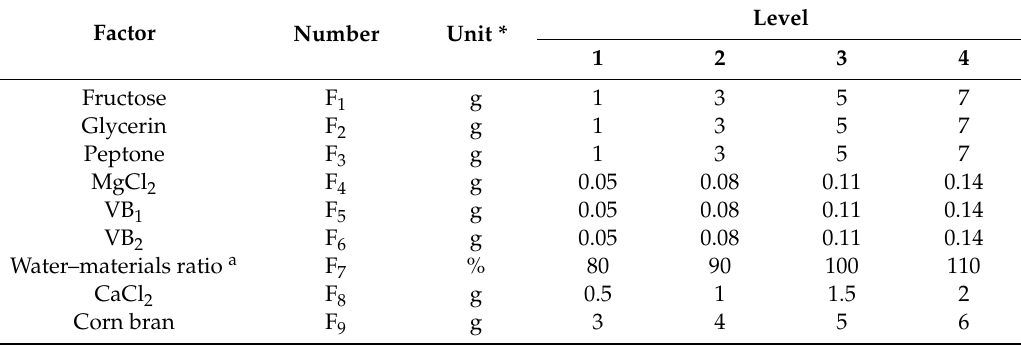
Table 1. The factors and levels of the orthogonal design.